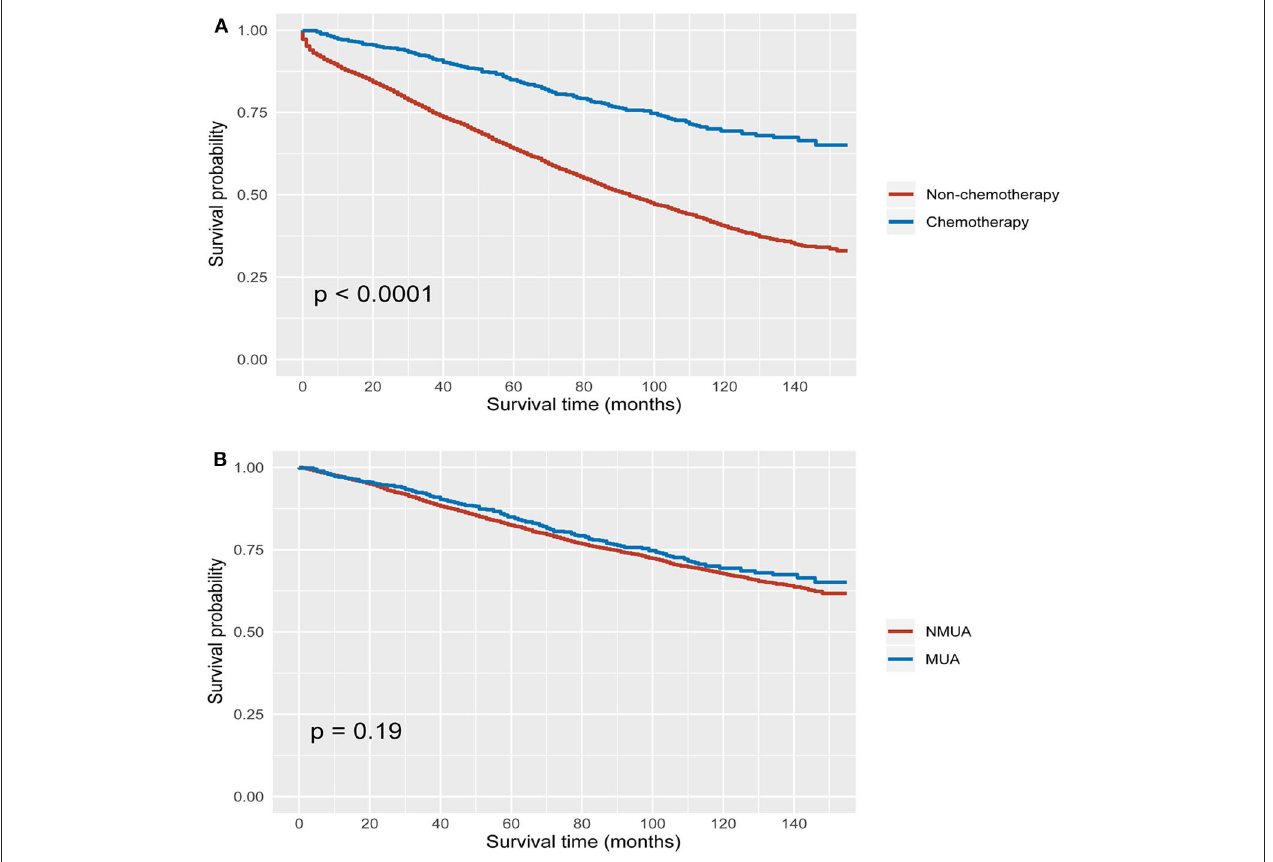
FIGURE 4 | Kaplan–Meier curves for overall survival in stage II colon cancer with (A) pT3 N0 M0 MUA, (B) pT3 N0 M0 colon cancer with the receipt of